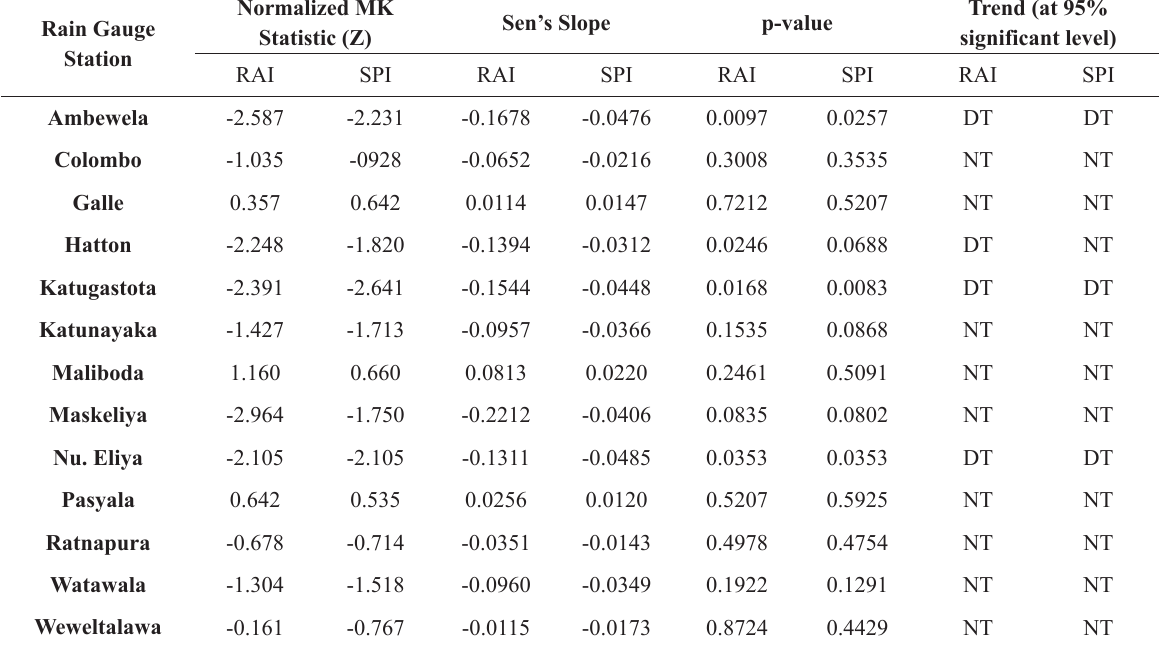
Table 3: Trend analysis on RAI and SPI for 13 rain gauge stations over the period 1981 - 2010 using MK test and Sen’s slope estimator. Rain Gauge